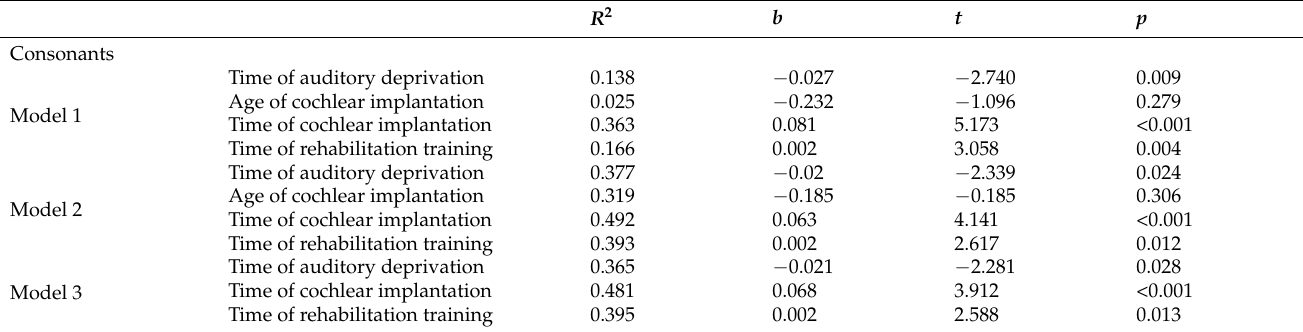
Table 2. Multiple linear regression analysis of factors associated with the SPA in CI